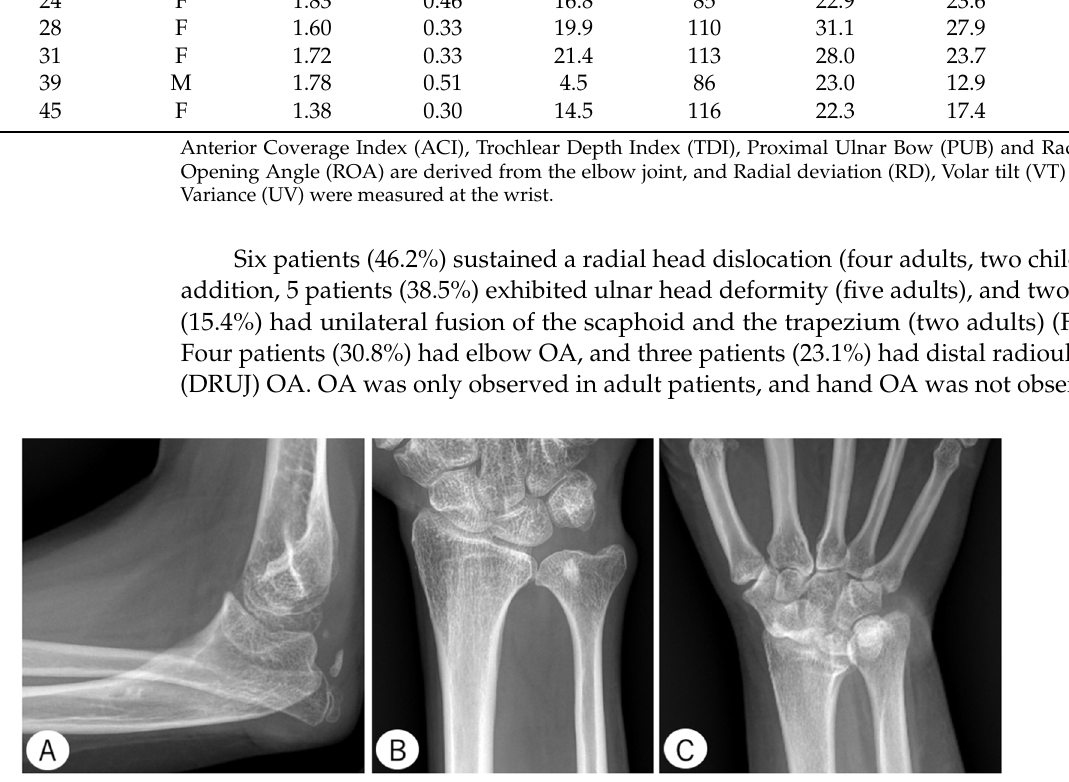
Table 4. Mean length and width of the phalangeal and metacarpal bones in adults (mm).